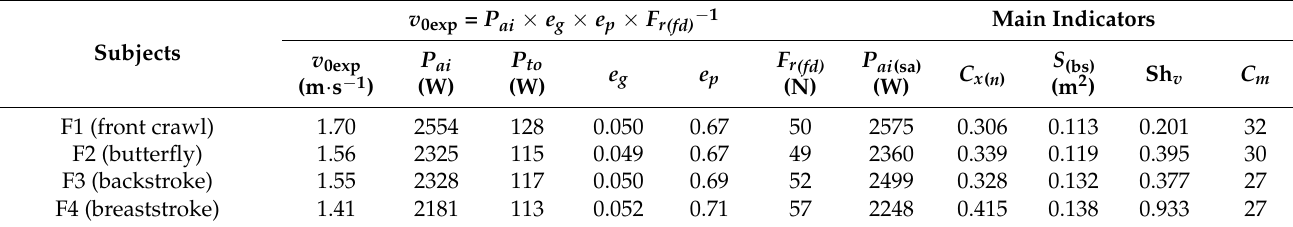
Figure 3. Relationships between v 0exp and e g in the swimming pool 8 × 100 m step-test for different swimming techniques in female ( A ) and male ( B ) subjects. Table 2. Numerical values of parameters of the mathematical model 1 and the main indicators for the female subjects in the last stage of the step-test.